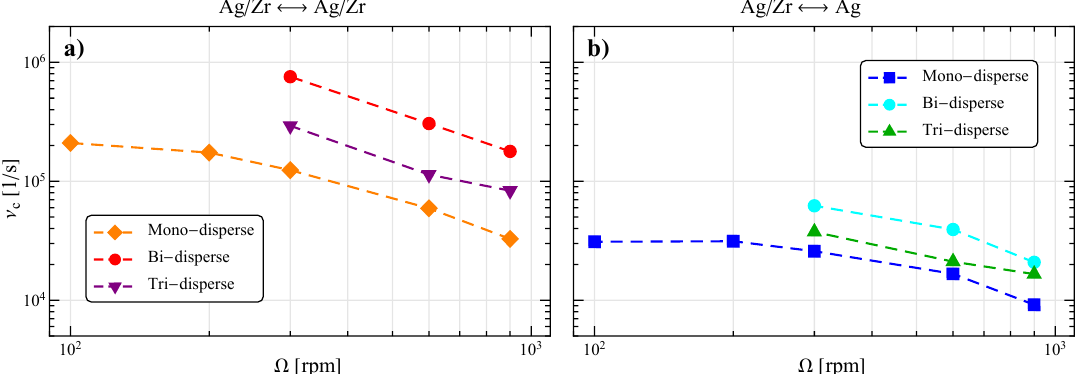
Figure 8. Collision frequency as a function of the stirring velocity for the impacts between all the particles ( a ) and those involving at least an Ag particle ( b